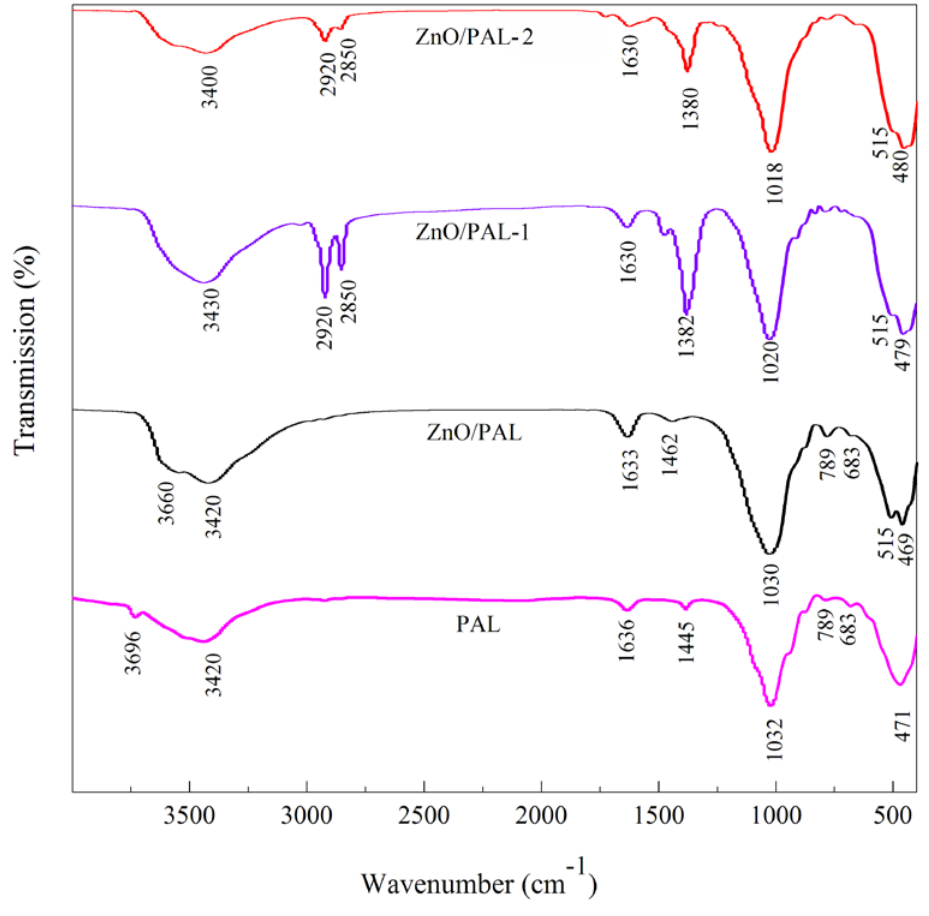
/ PAL, ZnO / PAL-1 and ZnO /